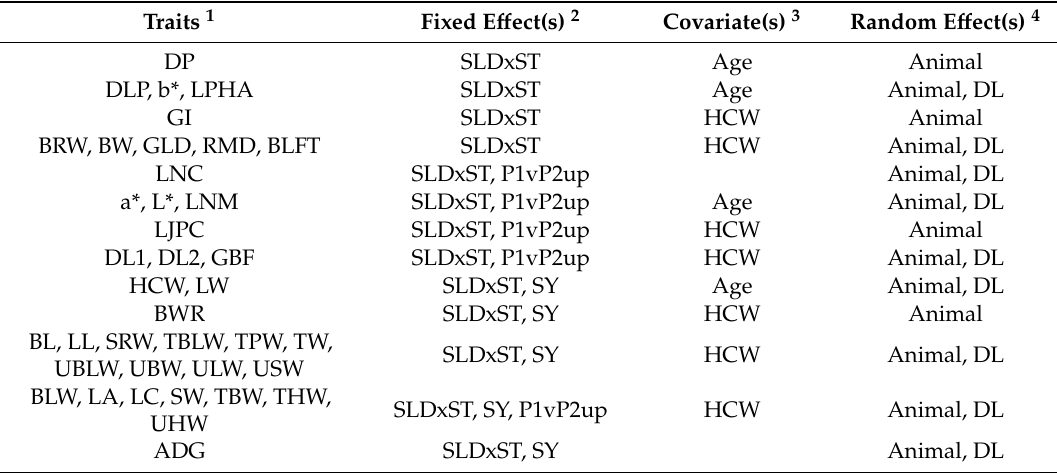
Table 3. Fixed and random e ff ects included in the statistical models used for the single and two-trait